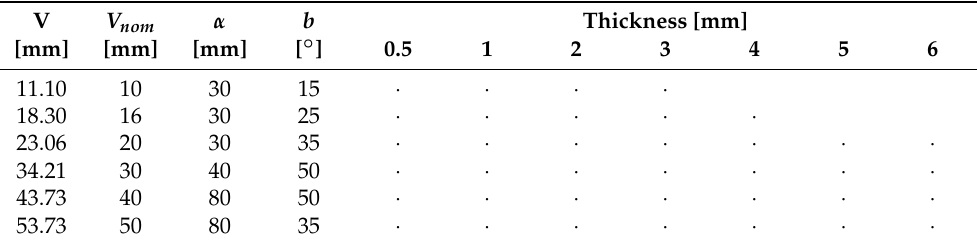
Table 5. Test combinations and dimensions for the tooling used in problem (b).